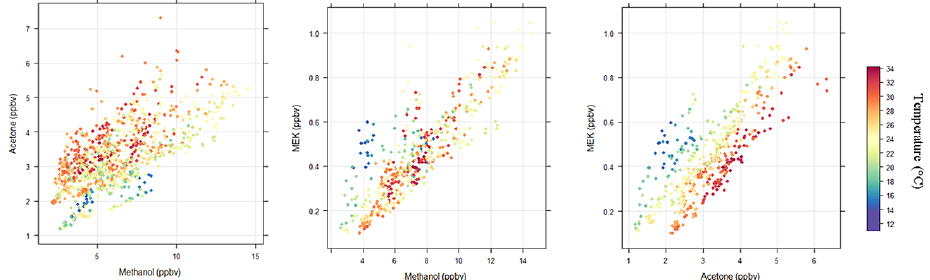
Figure 7. Scatter plots displaying the relationship between the mixing ratios by volume of methanol, acetone and MEK measured 4m above the canopy, coloured by